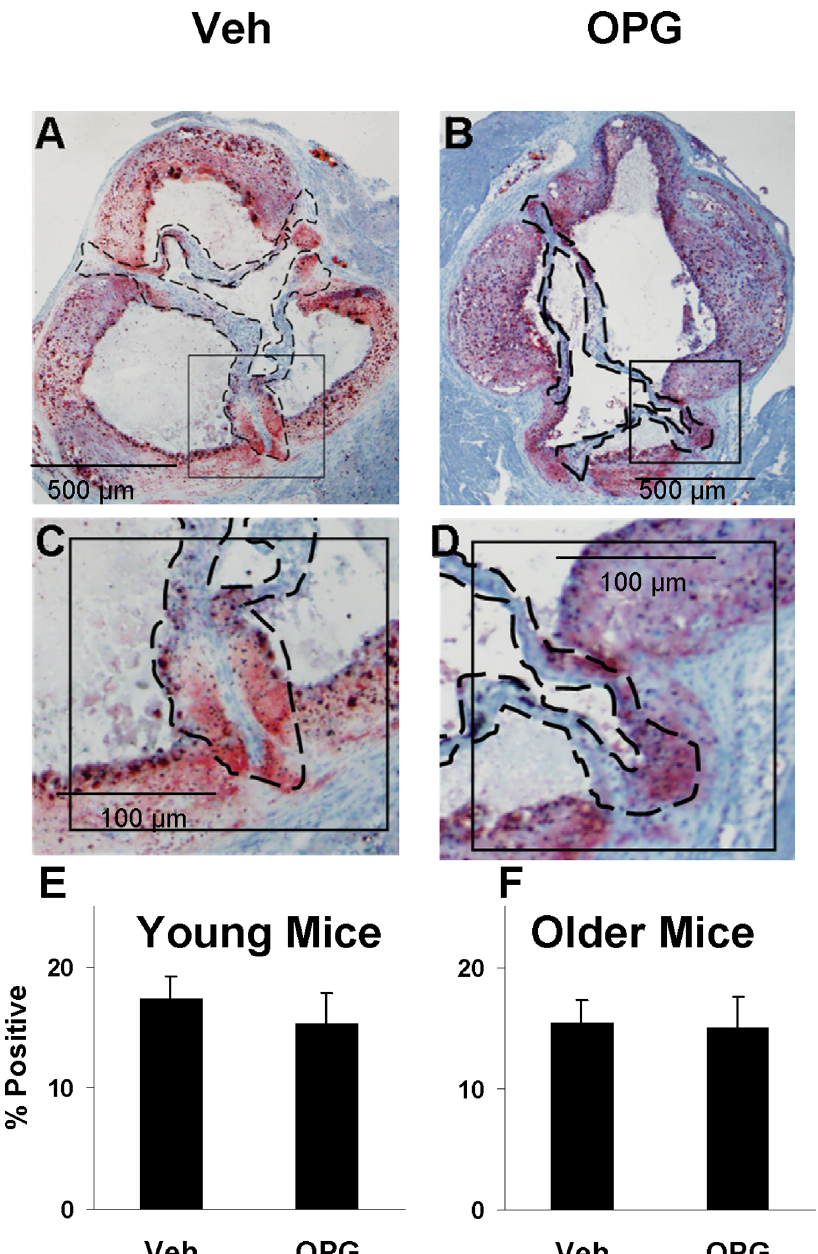
Figure 2. Lipid in the aortic valve. Oil Red-O staining is equally abundant in Older vehicle-treated mice (A,C) and OPG-treated Older mice (B,D). Group data for Younger mice (E) and Older mice (F). N=7–8; p=NS for Veh vs. OPG.